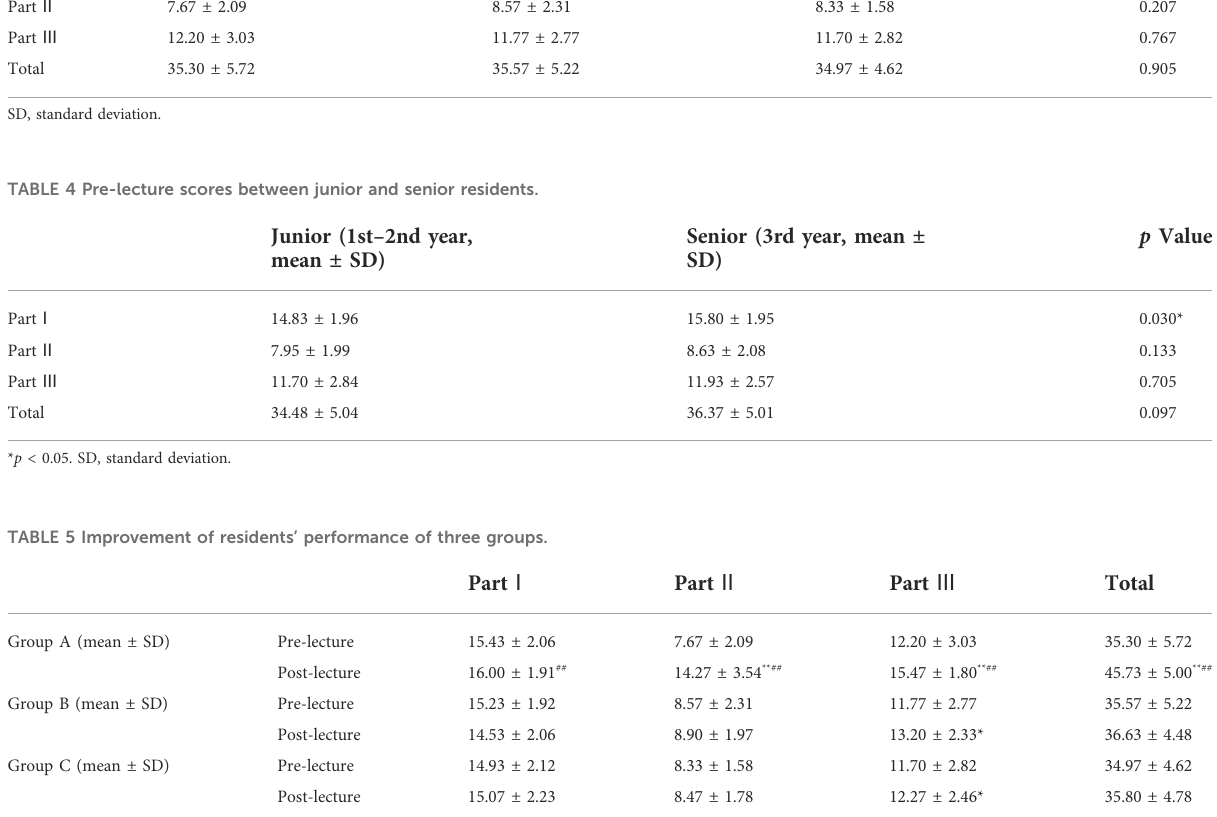
Ⅲ of post-lecture scores in group A were signi fi cantly higher than those in group B (Table 5, p < 0.01). However, there was no signi fi cant difference of post-lecture scores between group B and group C (Table 5, p = 0.489 for total scores, p = 0.340 for part Ⅰ scores, p = 0.375 for part Ⅱ scores, p = 0.137 for part Ⅲ scores), which indicated a similar effect of training by different instructors.